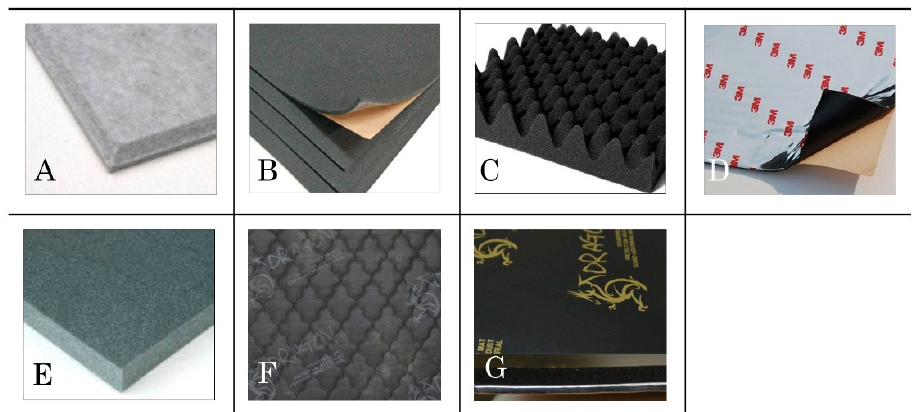
Figure 9. Types of soundproofing materials. ( A ) artboard; ( B ) rubber sound insulation; ( C )